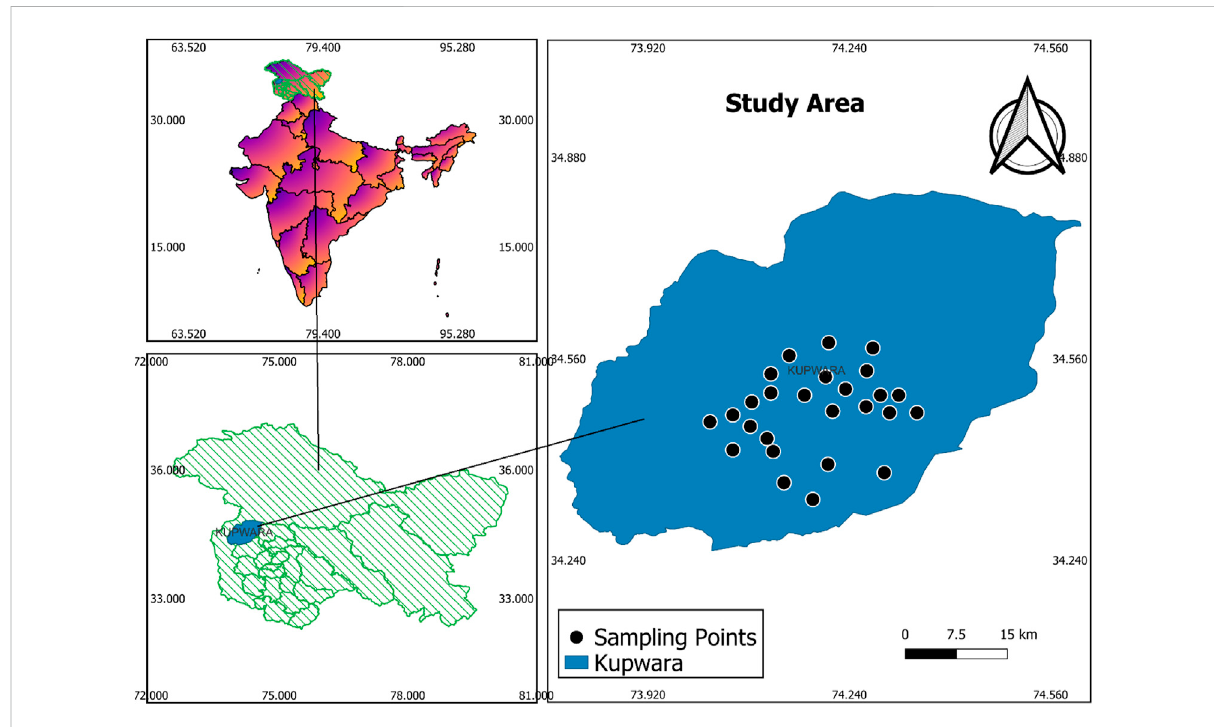
FIGURE 1 Land use systems of the study